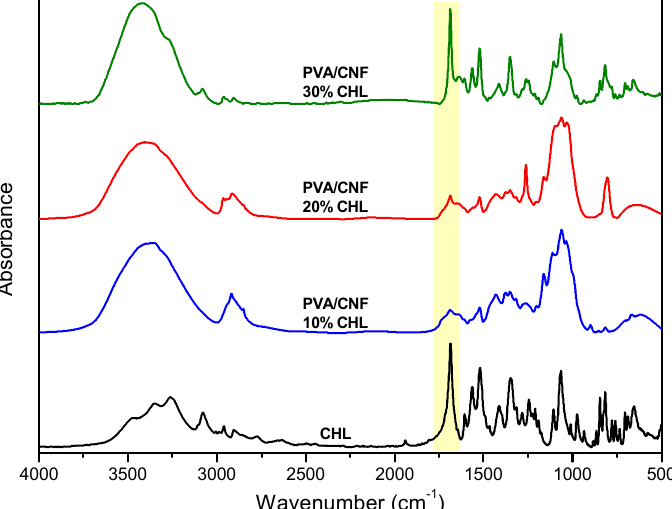
Figure 5. Infrared spectra of the prepared poly(vinyl alcohol) (PVA)/cellulose nanofibrils (CNF)/chloramphenicol (CHL) sponges with different CHL ratios. XRD was used to identify the physical state of the drug in the PVA/CNF composites after drug loading. In the case of the pure CHL, the diffractogram (Figure 6) showed that the active pharmaceutical ingredient (API) is highly crystalline, with clear XRD peaks appearing at 2 θ = 7.8 ◦ , 10.7 ◦ , 12.8 ◦ , 15.5 ◦ , 18.8 ◦ , 19.7 ◦ , 20.1 ◦ , 20.5 ◦ , 25.7 ◦ , 30.5 ◦ , and 31.4 ◦ . In the case of CHL loaded blends, amorphous API dispersions are observed at up to 20% w / w of drug loading, while crystalline peaks of CHL are observable in the diffractogram of the sponge containing 30% of CHL, probably due to some partial recrystallization of CHL or some superficial deposition [3,49].